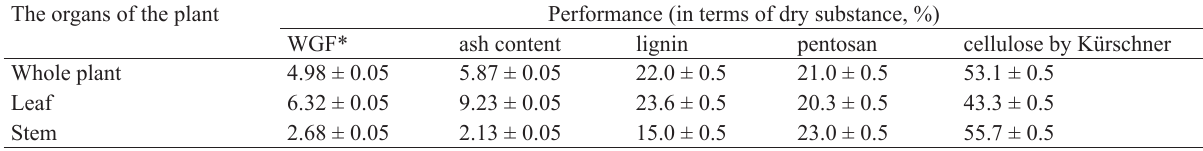
Table 2 Chemical composition of the Soranovski plant variety The organs of the plant Performance (in terms of dry substance, %)